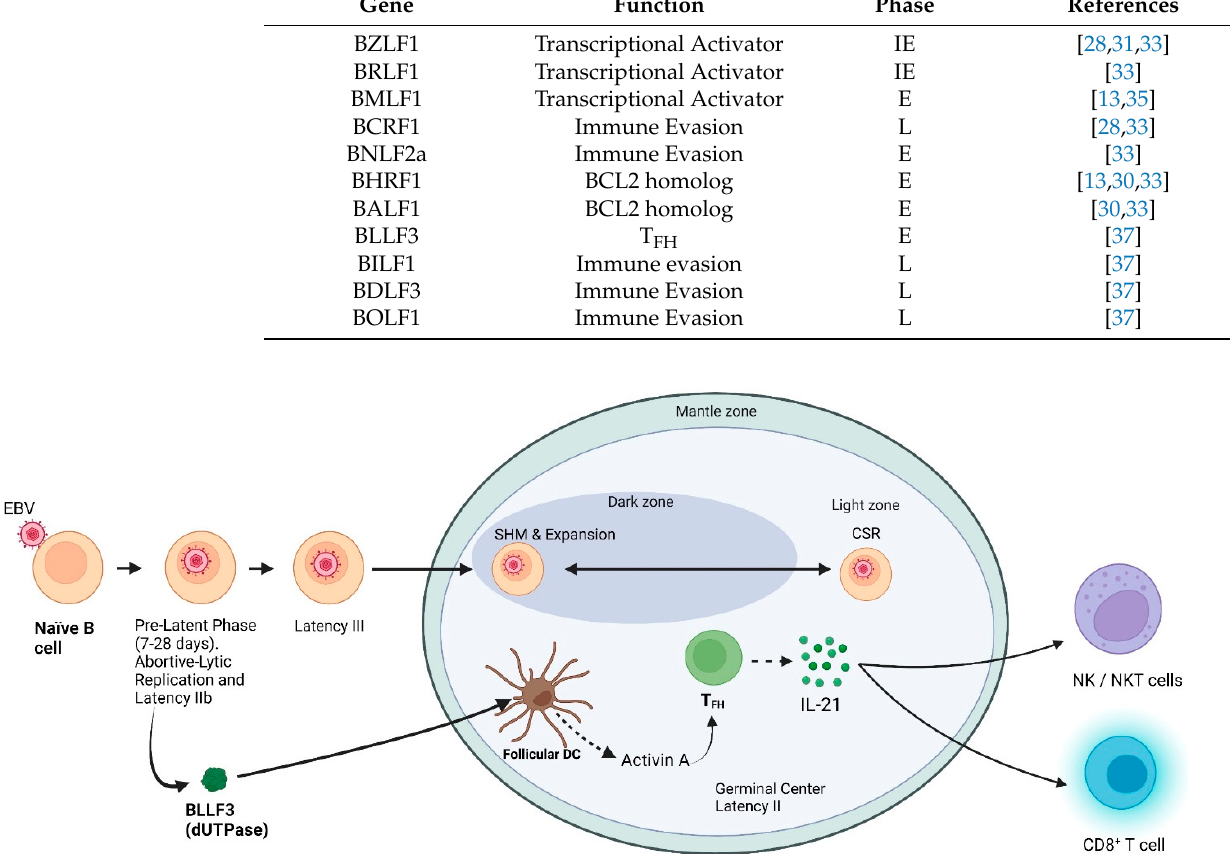
Figure 3. Schematic diagram showing actions of the EBV dUTPase protein contributing to the development of follicular T cells and the subsequent production of IL-21 during the pre-latent phase. BZLF1 encodes for Zebra (Zta), an IE protein and important transcriptional regulator.